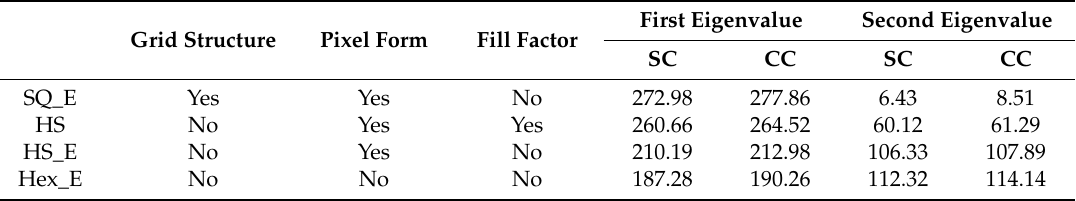
Figure 8. The first ( Top ) and second ( Bottom ) eigenvalues of the gradient values in a cross comparison between original image and four types of generated images. The blue lines represent the Hex_E images; the red lines represent the SQ_E images, the green lines represent the HS_E and the black lines represent the HS images. The continuous lines and dash lines represent the CC and SC images respectively. Table 1. The summery of the comparison results of the two figures in Figure